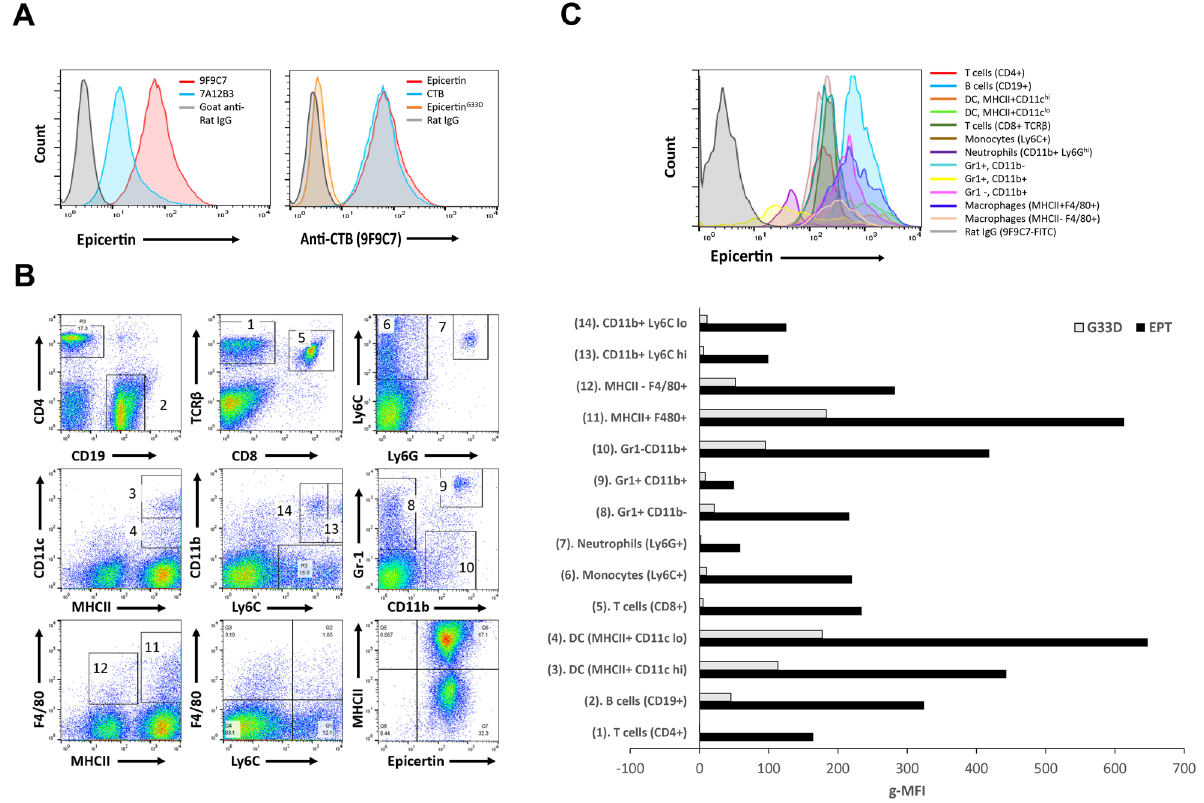
Figure 6. The 9F9C7 mAb detects EPICERTIN but not EPICERTIN G33D bound to the surface of human Caco2 cell line and to mouse spleen leukocytes. ( A ) Flow cytometry analysis of EPICERTIN binding to Caco2 cells detected with 2 µg/mL of 7A12B3 or 9F9C7 mAbs followed by FITC-labeled goat-anti-rat IgG (left panel). Detection of EPICERTIN, CTB and EPICERTIN G33D (2 µg/mL) binding to human Caco2 cell line detected with anti-CTB 9F9C9 mAb (right panel). ( B ) Staining pattern and gated spleen leukocytes that were screened for EPICERTIN and EPICERTIN G33D binding by flow cytometry. Spleen leukocytes were incubated with 5 μg/ mL of EPICERTIN or EPICERTIN G33D for 30 min on ice and then stained with a panel of fluorochrome-labeled antibodies and FITC-conjugated 9F9C7 anti-CTB mAb. ( C ) Histograms and geometric mean fluorescence intensity of EPICERTIN and EPICERTIN G33D bound to the mouse spleen leukocytes gated in panel